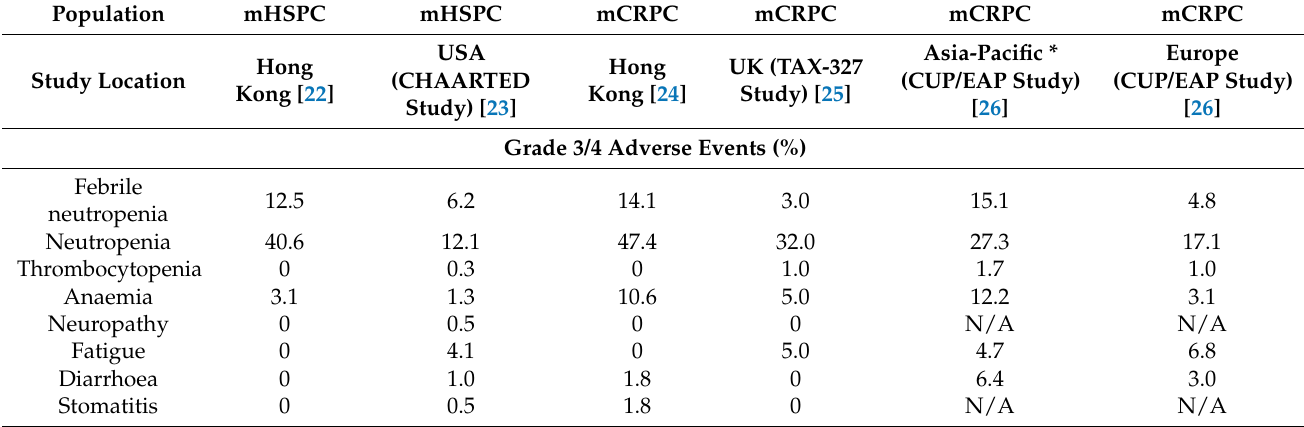
Table 1. Comparison of grade 3 and 4 adverse events (AEs) related to taxane treatment in studies of Asian and Western